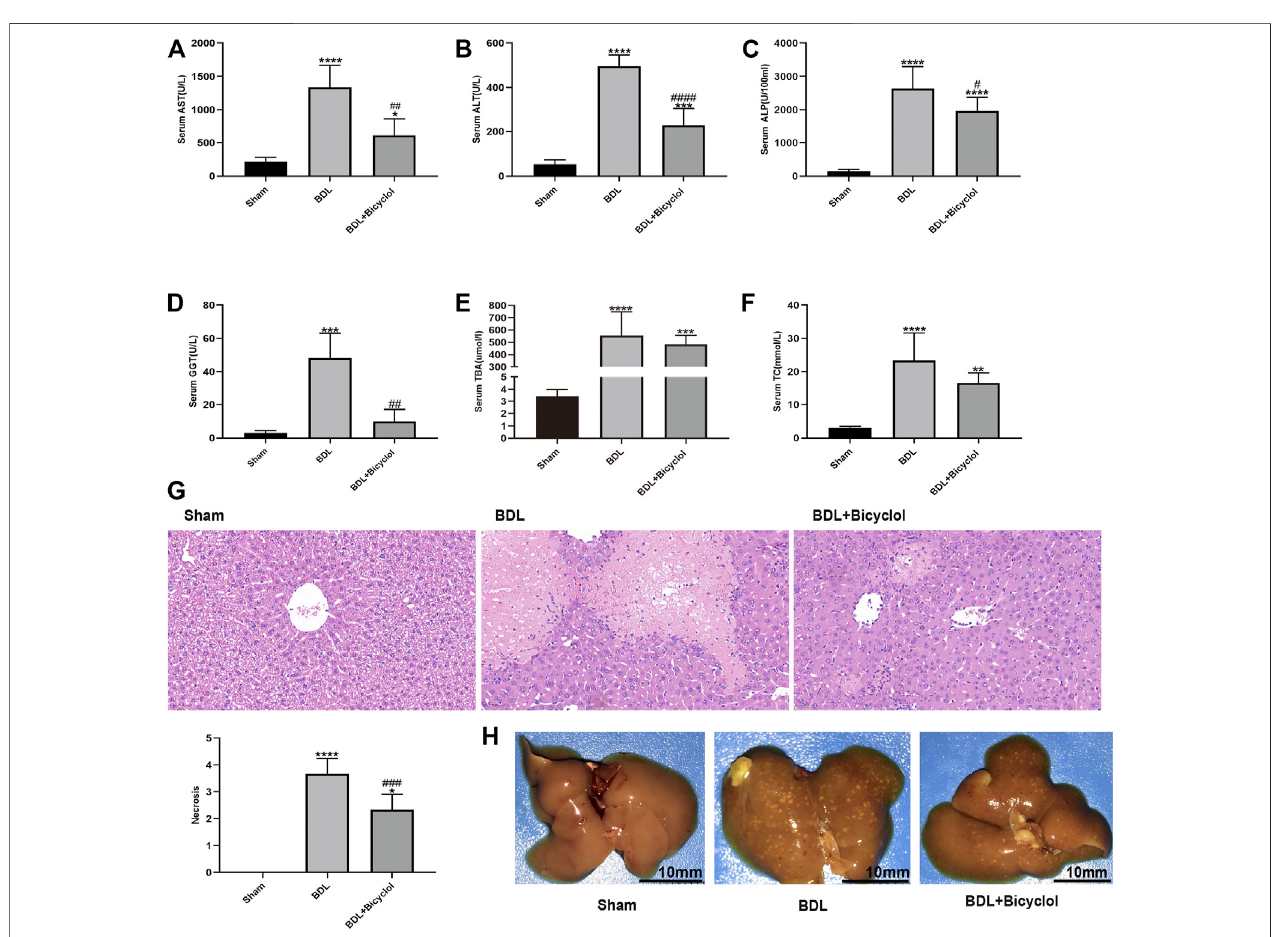
FIGURE 1 | Bicyclol markedly improved the liver enzyme, histology, and liver gross appearance in BDL mice. (A – F) Serum biochemistry including AST, ALT, ALP, GGT, TBA, and TC. (G) H&E stain liver histology (Scale bar, 100 um). (H) Gross liver appearance (Scale bar, 10 mm). AST, aspartate aminotransferase; ALT, alanine aminotransferase; ALP, alkaline phosphatase; GGT, γ -glutamyl transpeptidase; TBA, total bile acid; TC, total cholesterol. * p < 0.05, ** p < 0.01, *** p < 0.001, **** p < 0.0001 vs. sham; # p < 0.05, ## p < 0.01, ### p < 0.001, #### p < 0.0001 vs. BDL.